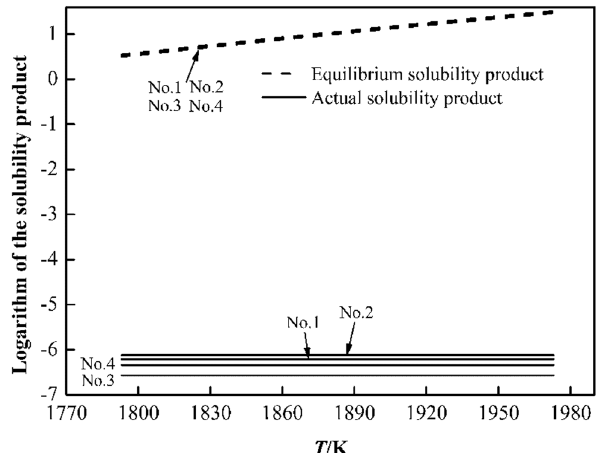
Figure 2: Logarithm of the solubility product as a function of temperature for MnS in the liquid